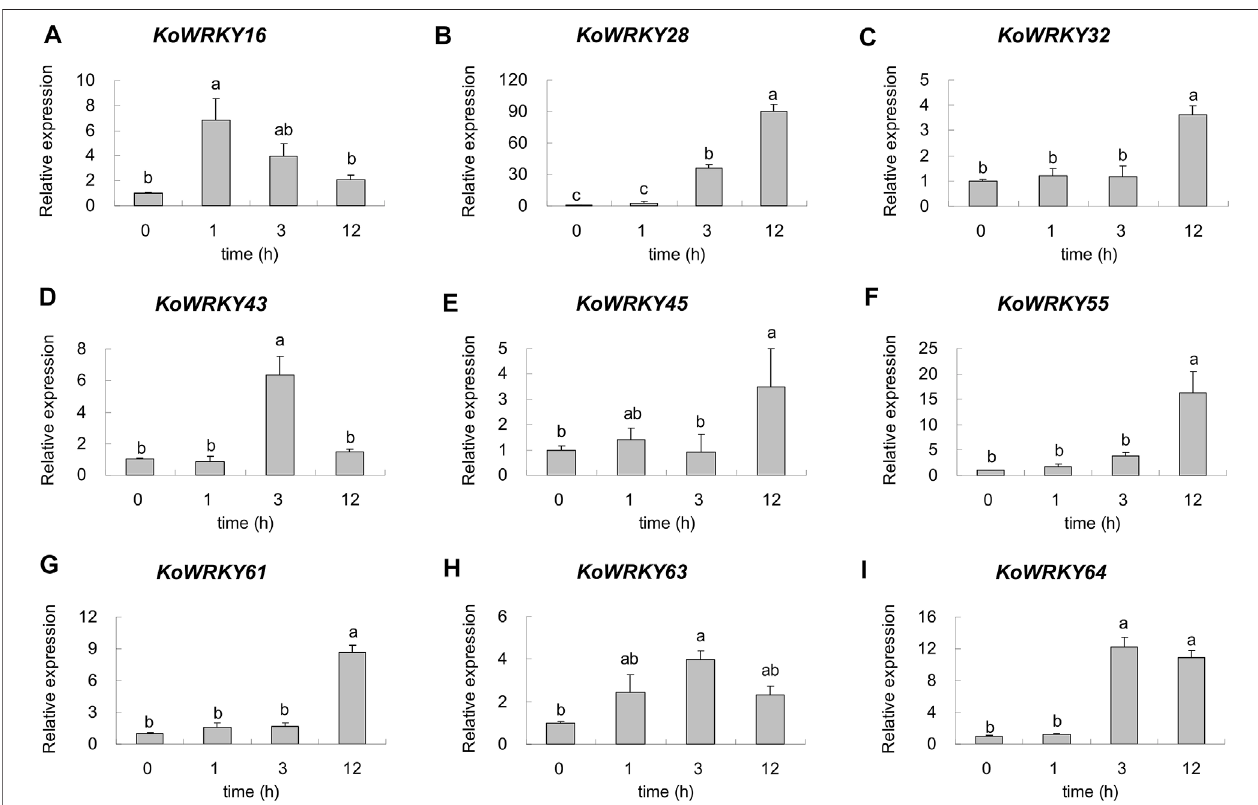
FIGURE8| Expressionpro fi lesofnineselected KoWRKY genesinresponsetochillingstress.Therelativeexpressionlevelsofnine KoWRKY genesweremeasured inplantssubjectedto4 ° Cfor0,1,3,and12 h.Thetranscriptlevelsoftheselectedgeneswereassessed via qRT – PCRandnormalizedto18SrRNAlevels.Theerrorbars represent the standard errors. The values with the same letter are not signi fi cantly different according to Duncan ’ s multiple range test ( p < 0.05, n = 3). Panels (A – I) represented the expression level of gene KoWRKY16, KoWRKY28, KoWRKY32, KoWRKY43, KoWRKY45, KoWRKY55, KoWRKY61, KoWRKY63 , and KoWRKY64 ,